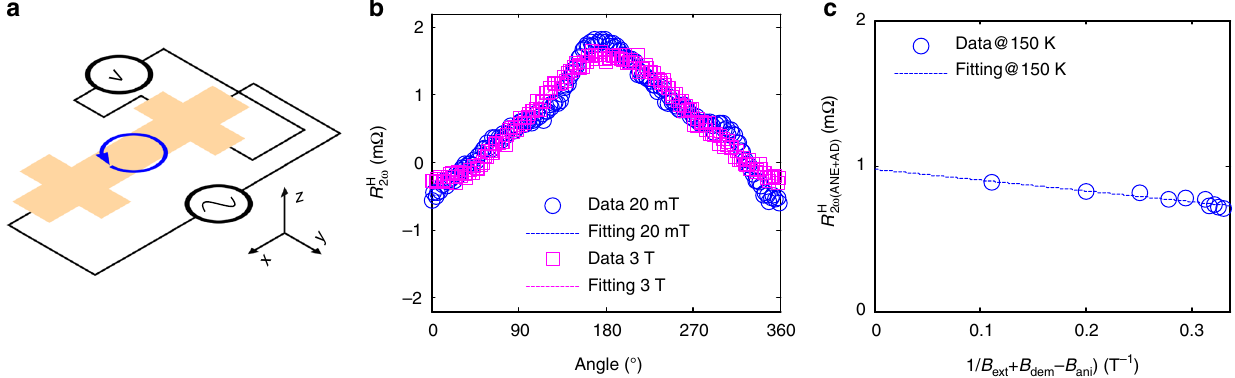
Fig. 3 Hall resistance. a Hall/transverse resistance measurement setup. b Examples of second harmonic Hall resistance of 10 QL BST sample at 150 K vs angle in xy plane rotation with 20 mT and 3 T external fi elds. c Hall resistance measured with various external fi elds is plotted vs reciprocal of total fi eld. The dashed line is a linear fi t to the data; the intercept of the fi tted line represents the contribution of